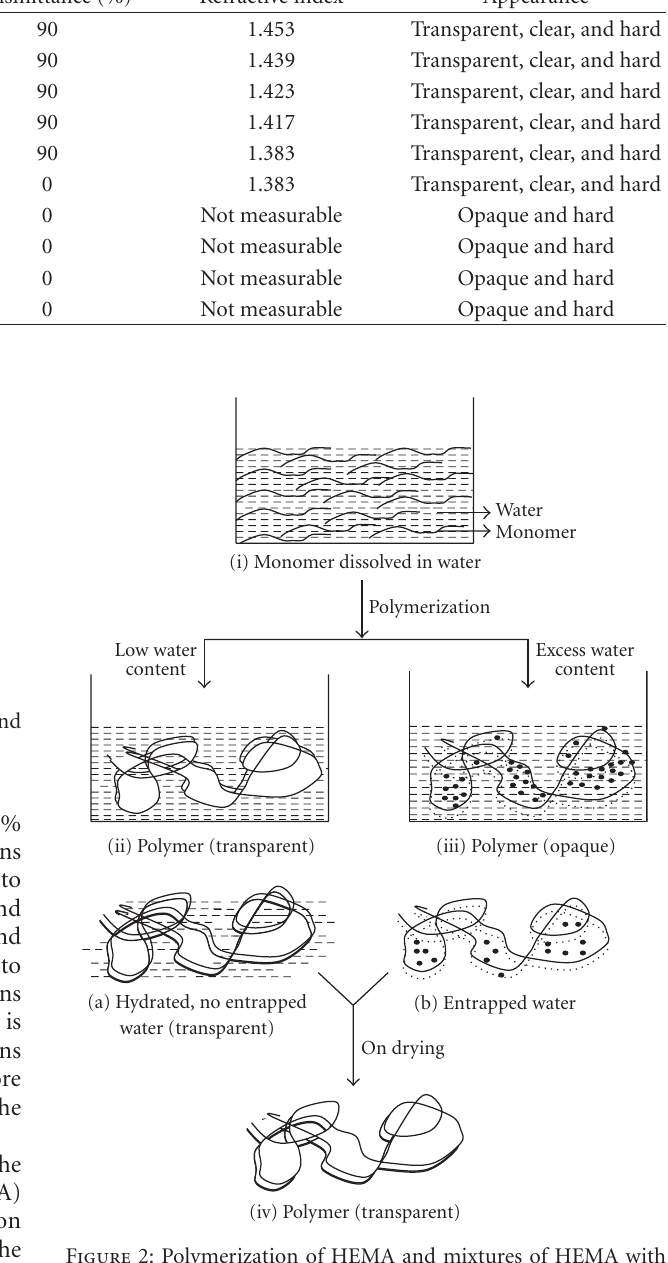
Figure 2: Polymerization of HEMA and mixtures of HEMA with other monomers in the presence of water (i) solution of monomer or monomer mixture in water, (ii) hydrated polymer without entrapped water remains transparent, (iii) hydrated polymer with entrapped water appears opaque, and (iv) dehydrated polymer from both the hydrated, transparent and opaque